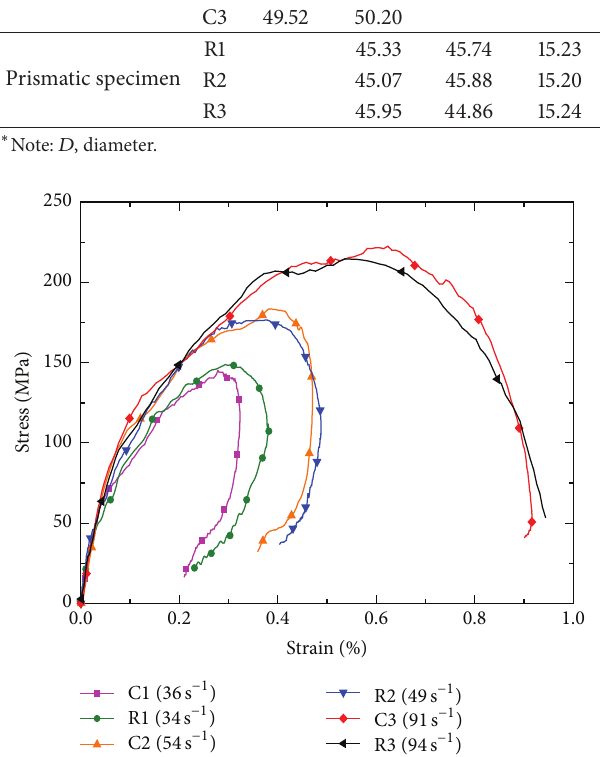
Figure 8: Comparison of the dynamic stress-strain curves of cylindrical and prismatic specimens under different strain rates (C represents circular cross-section; R represents rectangular cross-